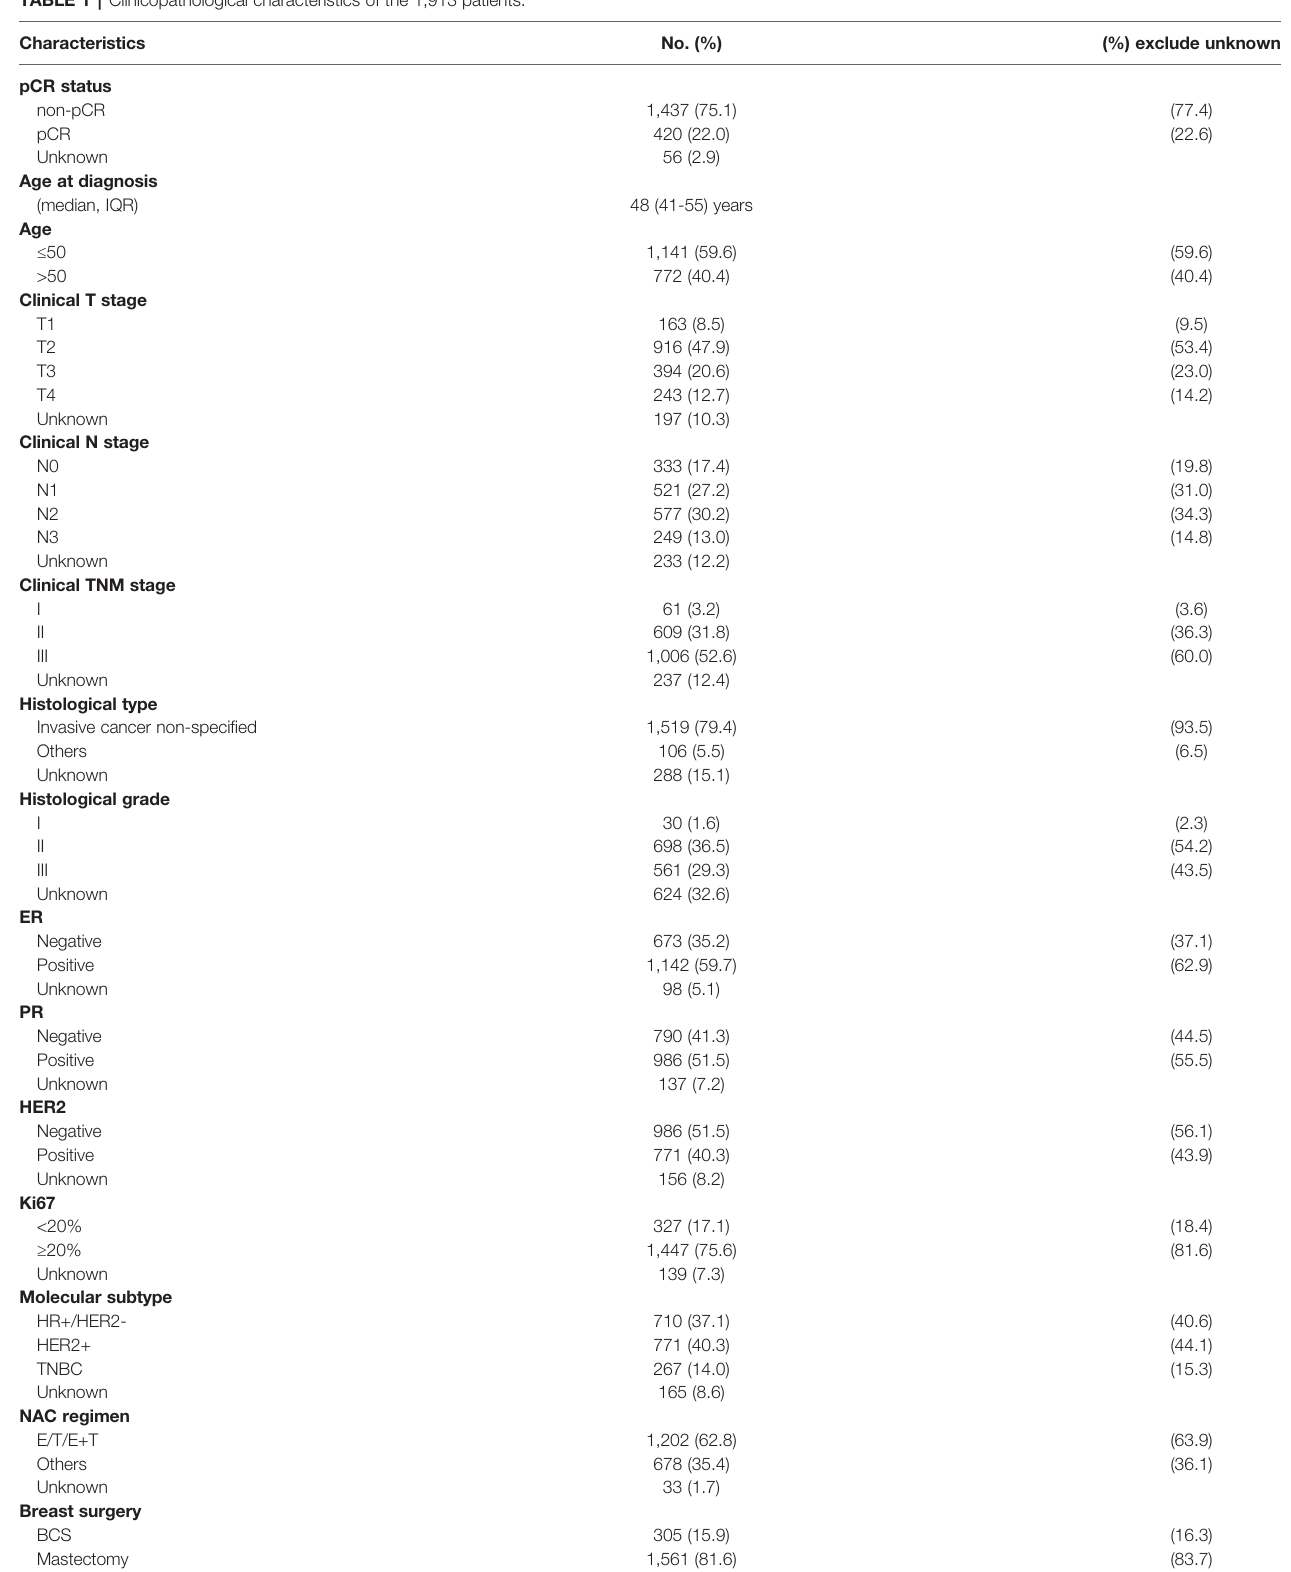
TABLE 1 | Clinicopathological characteristics of the 1,913 patients.